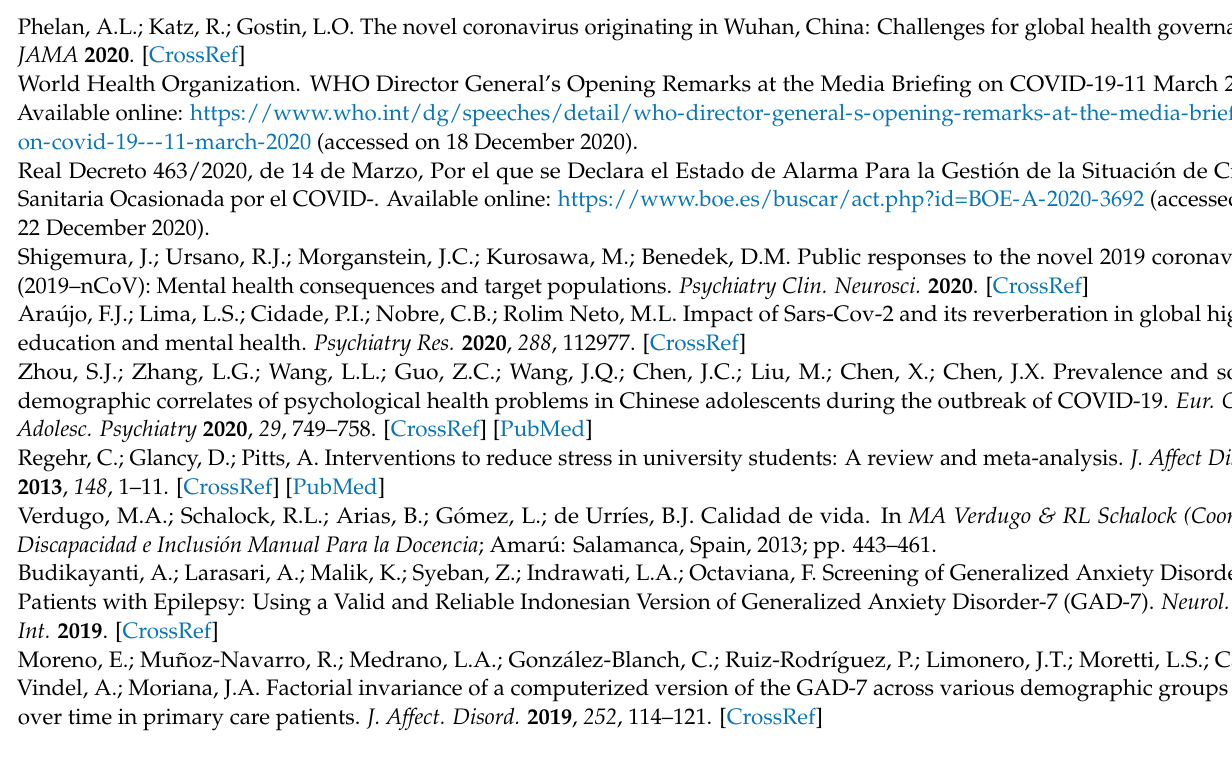
family income affected negatively, Table S3: Association between GAD-7 and feeling fear. Table S4: Association between GAD-7 and negatively affected sleep patterns, Table S5: Association between GAD-7 and relationship with family, Table S6: Association between GAD-7 and if their habits help them during this period, Table S7: Association between GAD-7 and feeling calm and relaxed, Table S8: Association between GAD-7 with the death of a relative or a